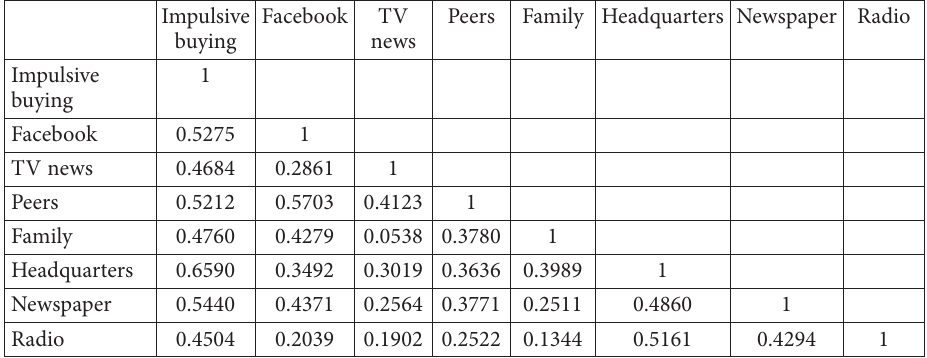
Table 5. Results of correlation matrix (source: prepared by